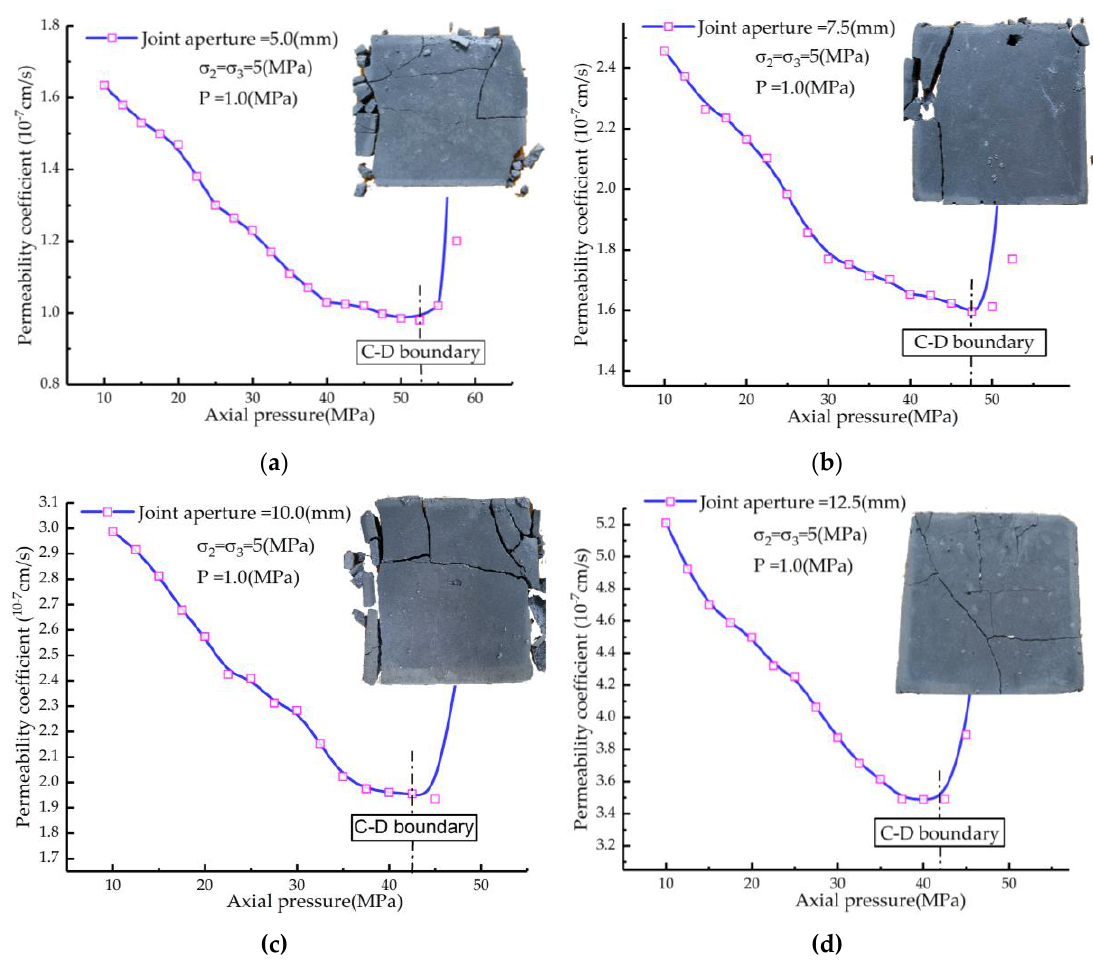
Figure 10. E ff ect of the maximum principal stress loading failure process on the permeability changes in the specimens with infilled fractures: ( a ) fracture aperture of 5 mm; ( b ) fracture aperture of 7.5 mm; ( c ) fracture aperture of 10 mm; ( d ) fracture aperture of 12.5 mm.